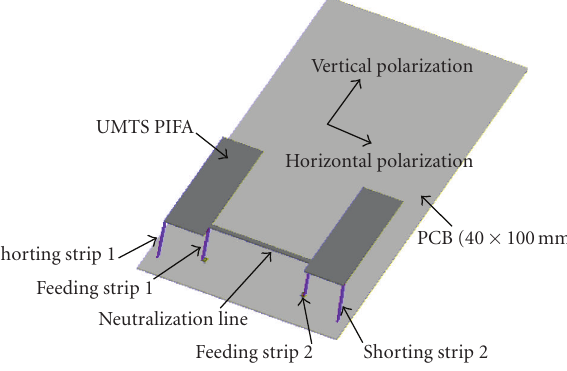
Figure 3: 3D view of the neutralized two-antenna system.